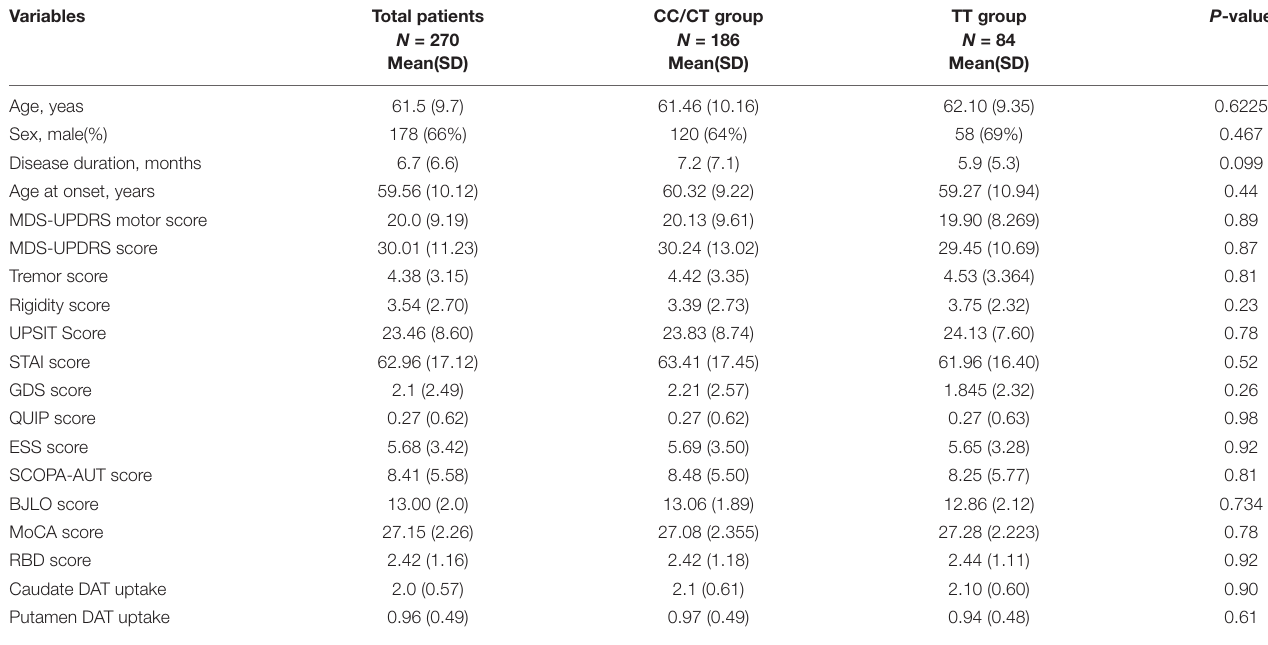
TABLE 1 | Baseline characteristics in the rs3910105 C allele group and TT